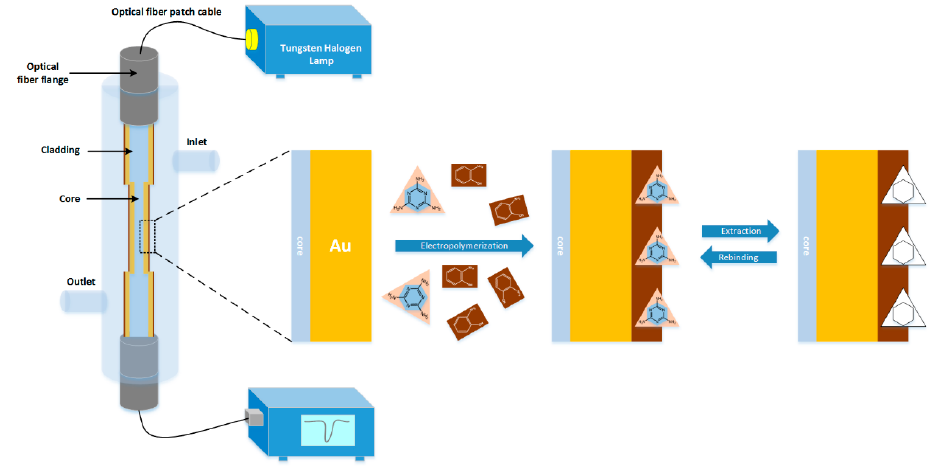
Figure 1. Schematic diagram of the experimental setup and the fabrication process of PoAP–MEL probe.